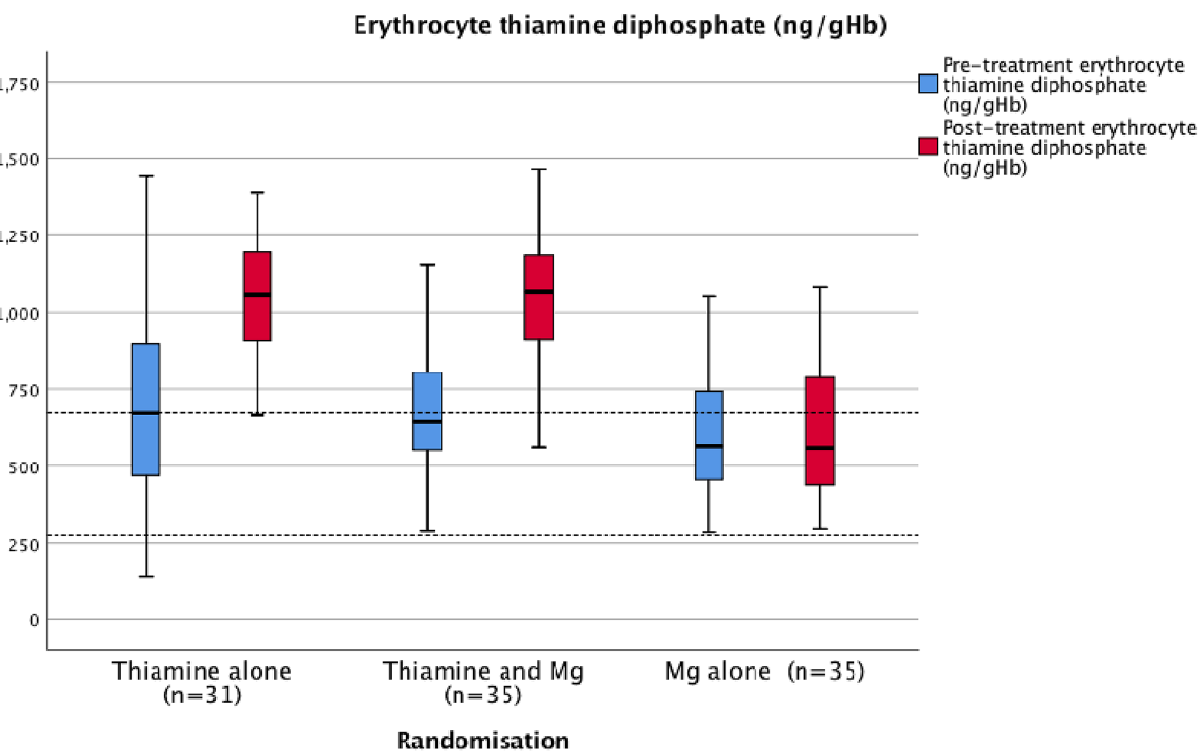
Figure 2. Pre- and post-treatment erythrocyte thiamine diphosphate concentrations.